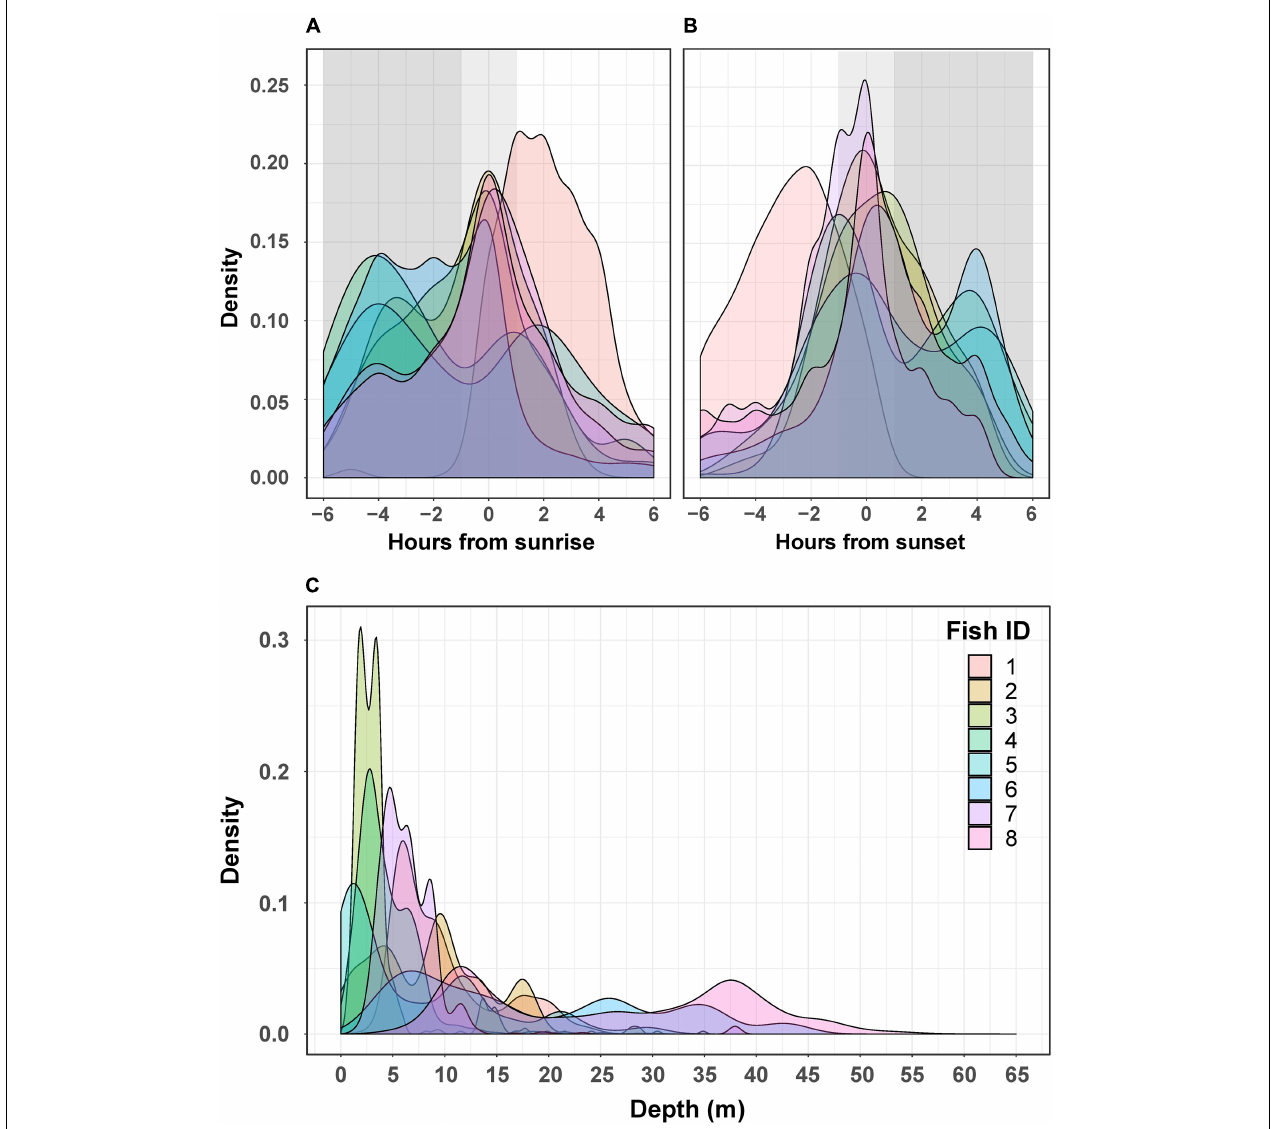
FIGURE 2 | Activity (A,B) and depth (C) for each tagged P. miles . The top two graphs depict the density of active detection relative to time from sunrise (A) and time from sunset (B) . Active detections were defined as the 30% most active half hours for each fish. The shaded dark gray areas represent night, and the light gray represents crepuscular hours ( ± 1 h from sunset/sunrise). The bottom graph (C) shows the densities of detected depths for each individual.